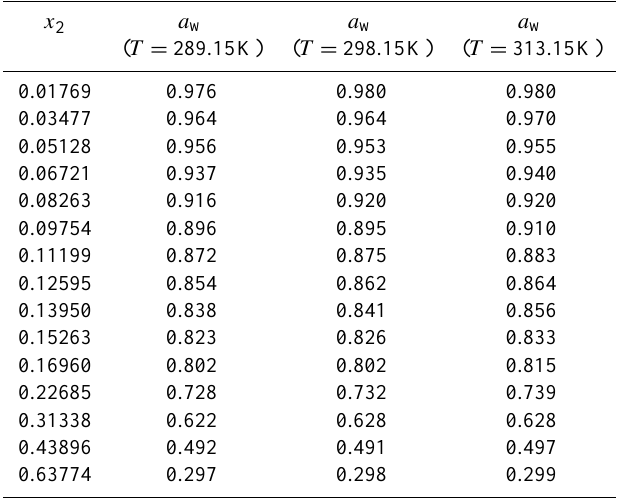
Table A1. Bulk water activity (a w ) measurements a of water (1) + glycerol (2) solutions at three different temperatures. Solution compositions are given in mole fraction of the organic component (2), x 2 . x 2 a w a w